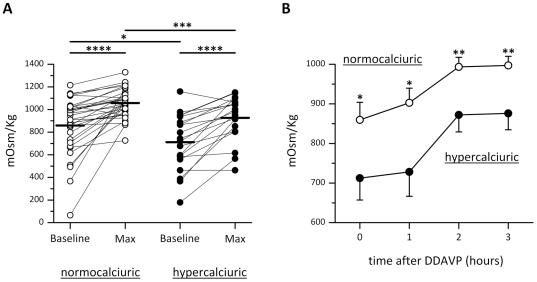
Urinary osmolality during DDAVP test.(A) Baseline and maximal urine osmolality after DDAVP test in normocalciuric and hypercalciuric patients. (B) Urinary osmolality in samples collected hourly after DDAVP administration. In hypercalciurics, DDAVP treatment was accompanied by a significantly lower increase in urinary osmolality, indicating a reduced urinary concentrating ability in response to vasopressin in hypercalciuric subjects. The values obtained were compared by one-way Anova and Tukey's multiple comparison test (*P<0.005, **P<0.001, ***P<0.0001.).